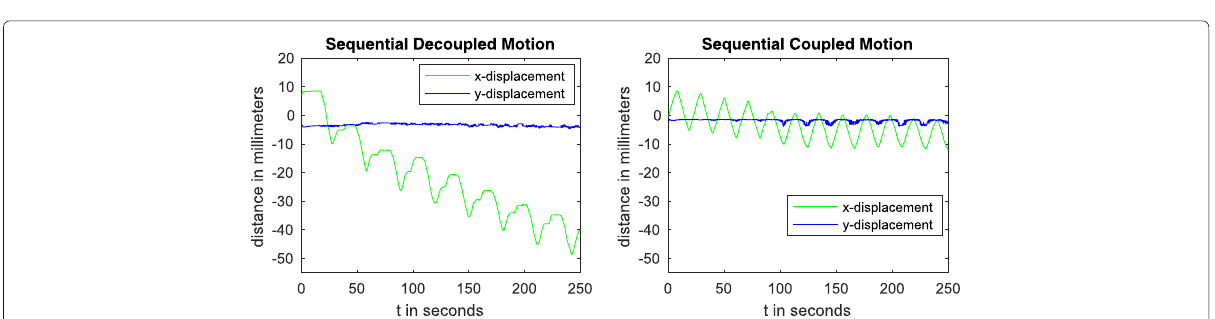
Fig. 27 These graphs compares the displacement produced by the decoupled sequential strokes (left picture) with the displacement from the coupled one (right picture). The motion takes over 5 minutes, the decoupled motion is composed of about 9 strokes while the coupled one does about 13 strokes (a 2/3 ratio which is expected since for the decoupled motion there are three leg motion and two for the coupled one). The drift for the decoupled motion is damped toward the end which is due to the copepod moving closer the boundary of the tank and experiencing its effects. We can observed a slight drift for the coupled motion as well due to our robotics copepod set-up being only an approximation of a Low-Reynolds number